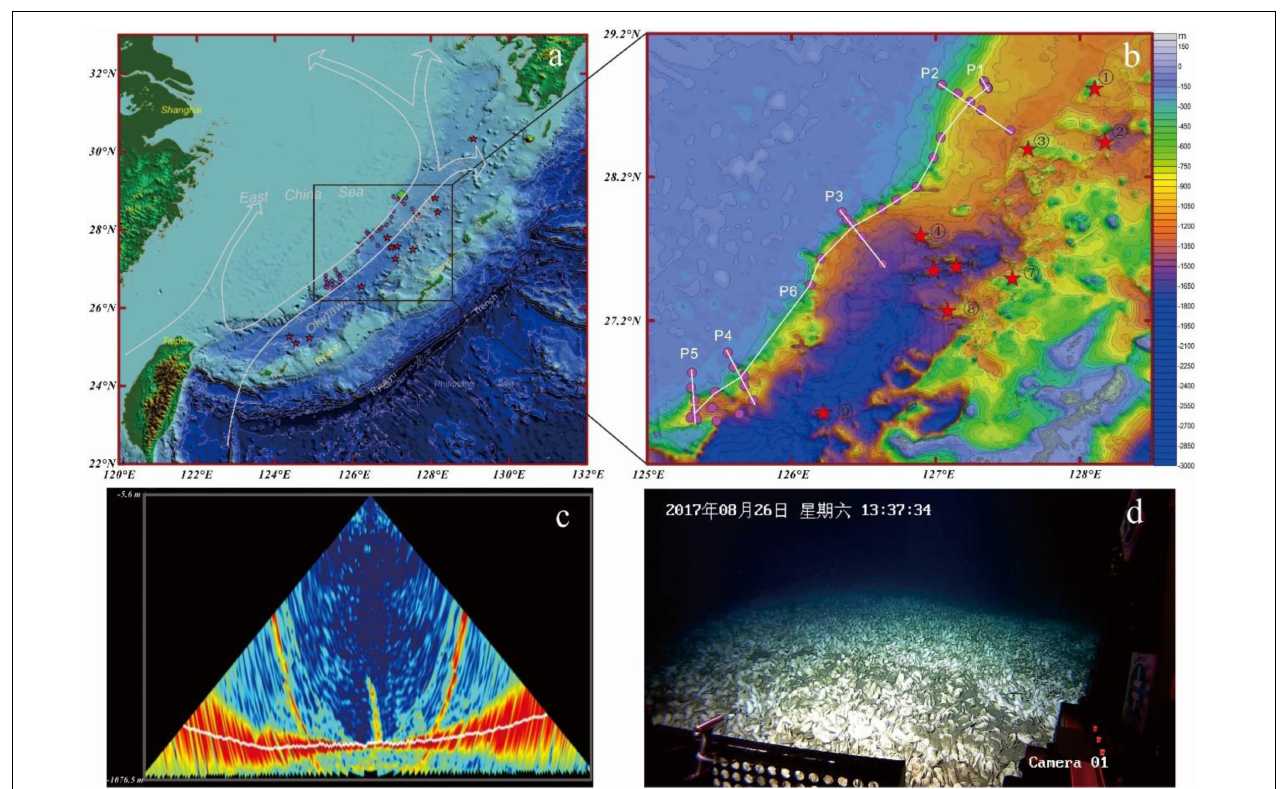
FIGURE 1 | (a) Observational regions and sampling stations in the OT, ECS during the integrated environmental and geological and ROV cruises during 2016 and 2017. The main stream of the Kuroshio Current is shown in solid curves; rose red solid circles represent seawater sampling locations; the green square represents cold seep (Li et al., 2015; Xu et al., 2018); red stars represent hydrothermal vent sites. The identified hydrothermal fields are cited from the InterRidge database (http://interridge.org/) and are listed as follows: (1) Site ES2, (2) Higashi-Ensei, (3) Minami-Ensei Knoll, (4) North Knoll, (5) Iheya Ridge, (6) Natsushima 84-1 Knoll, (7) Yoron Hole, (8) Izena Cauldron, and (9) Higa. (b) Location of sampling site with P1–P6, six transects; (c) acoustic flare representing seafloor methane bubble plume near the CTD10 site on the west slope of the OT. (d) ROV observations of in situ Giant clam beds made during the ROV cruises in